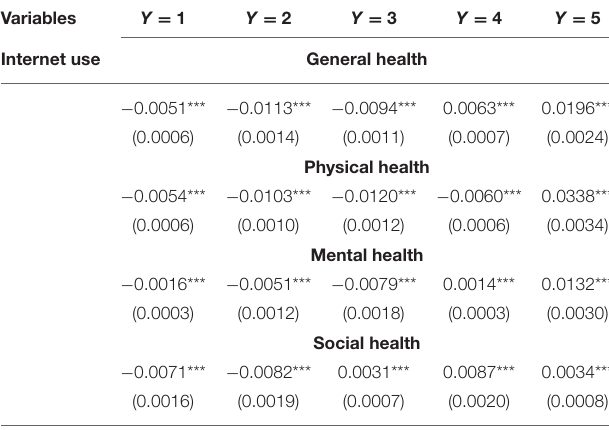
TABLE 2 | Ordered probit estimation of Internet use on individual multidimensional health. Variables